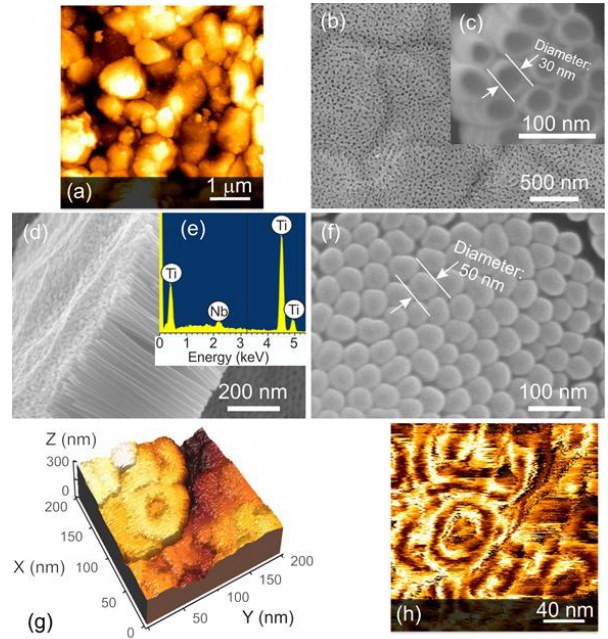
Figure 7. ( a ) 2D AFM topography of the alumina substrate. ( b ) Surface morphology of Nb-TiO 2 nanotubes, ( c ) magnification of ( b ), ( d ) cross-sectional view of the anodized layer ( e ) EDX spectrum confirming the presence of 4.5 ± 0.5 wt % of Nb with respect to Ti, ( f ) the bottom-view of the tubular layer. ( g , h ) AFM images of the single nanotubes: ( g ) 3D topography and ( h ) the associated phase signal. Reproduced with permission from [20]. Copyright (2014) Elsevier B.V.